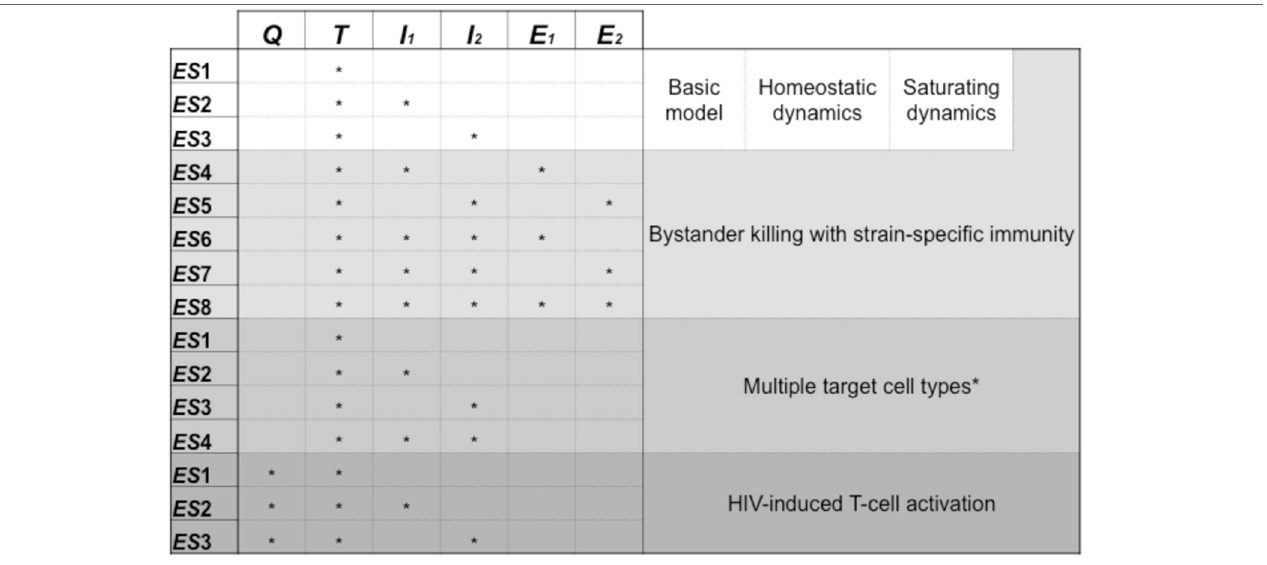
TABLE 2 | Summary of the possible equilibrium states in the analyzed models, showing the cell types that are present in each equilibrium point.